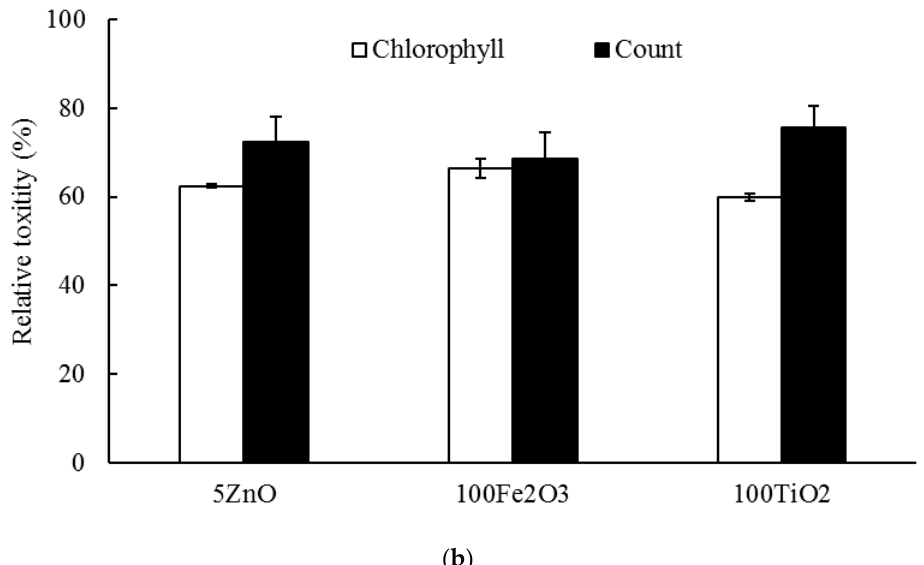
Figure 1. Toxic effects of NPs in two endpoints (cell count and chlorophyll content) of algal growth ( a ). Representative results of the most (5 mg/L ZnO) and least (100 mg/L of Fe 2 O 3 and TiO 2 ) toxic individual NPs ( b ). Comparisons were made based on the relative activity of the control set, 100% activity at no NPs amended condition.